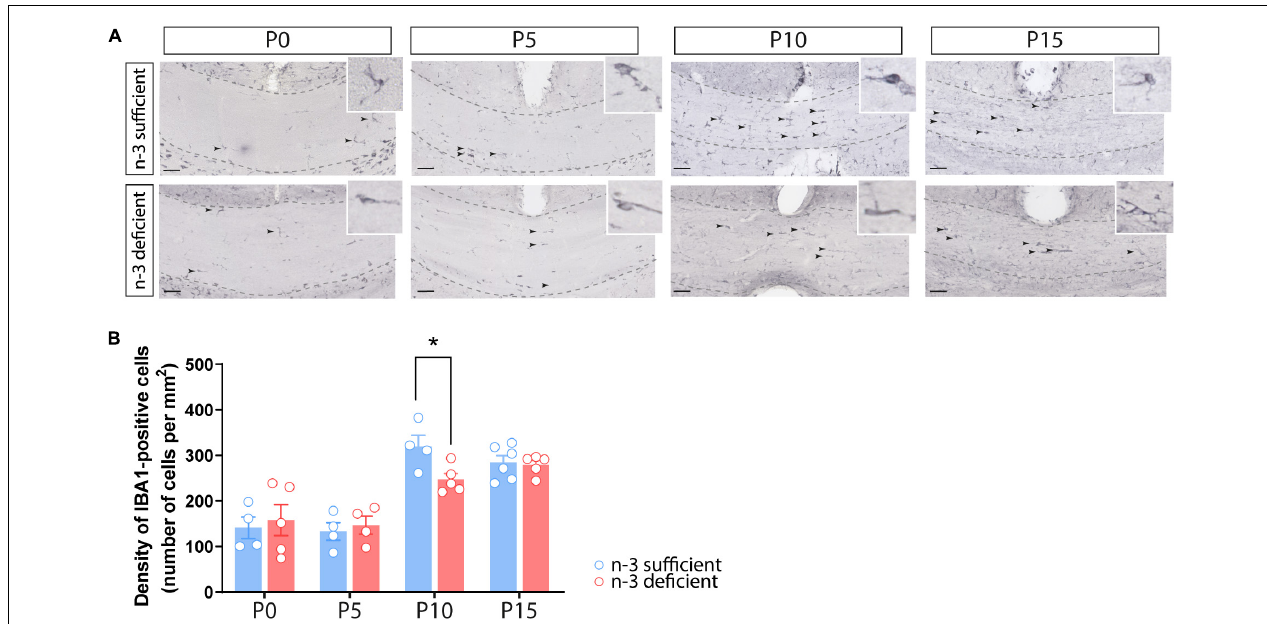
FIGURE 1 | Dietary n-3 PUFA deficiency decreases microglial density in the developing corpus callosum . (A) Representative images of Iba1-positive cells (arrow) at different post-natal ages (P0, P5, P10, and P15) in the corpus callosum of n-3 sufficient and n-3 deficient mice (scale bar = 50 µ m; dotted lines delineate the corpus callosum ). (B) Result of the quantification of Iba1-positive cell density, at different post-natal ages (P0, P5, P10, and P15) in the corpus callosum of n-3 sufficient and n-3 deficient mice. All data are presented as mean ± SEM. Blue bars/circles = n-3 sufficient mice, red bars/circles = n-3 deficient mice. n = 4–6 animals/group. * p <